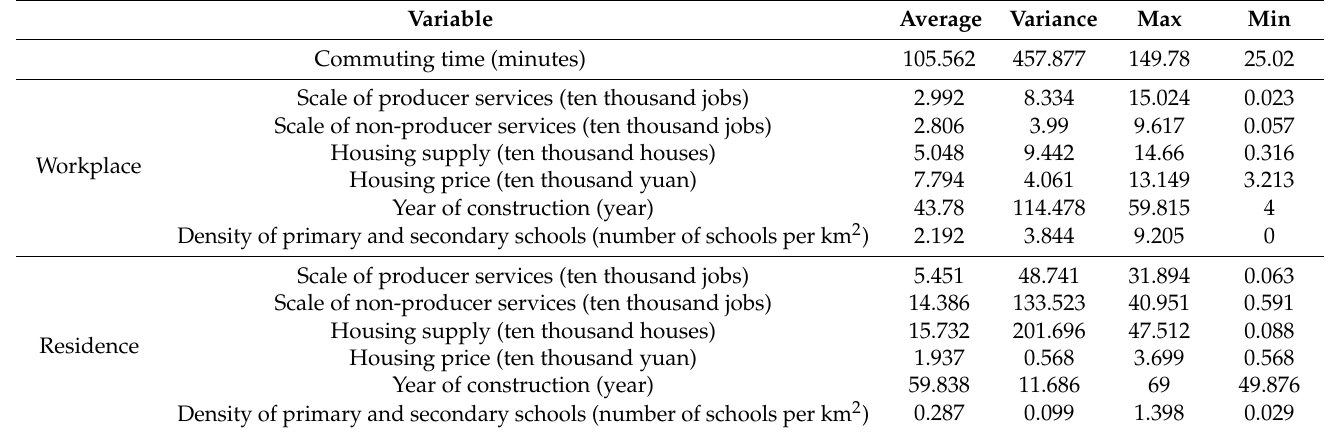
Table 3. Descriptive statistics of the independent variables of the intercity commuting flows from Suzhou to Shanghai.